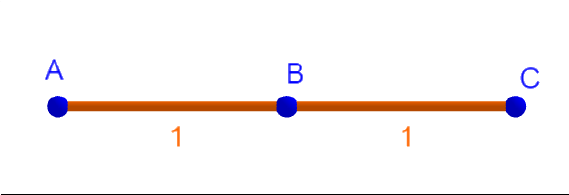
Figure 4. A linkage with different real/complex